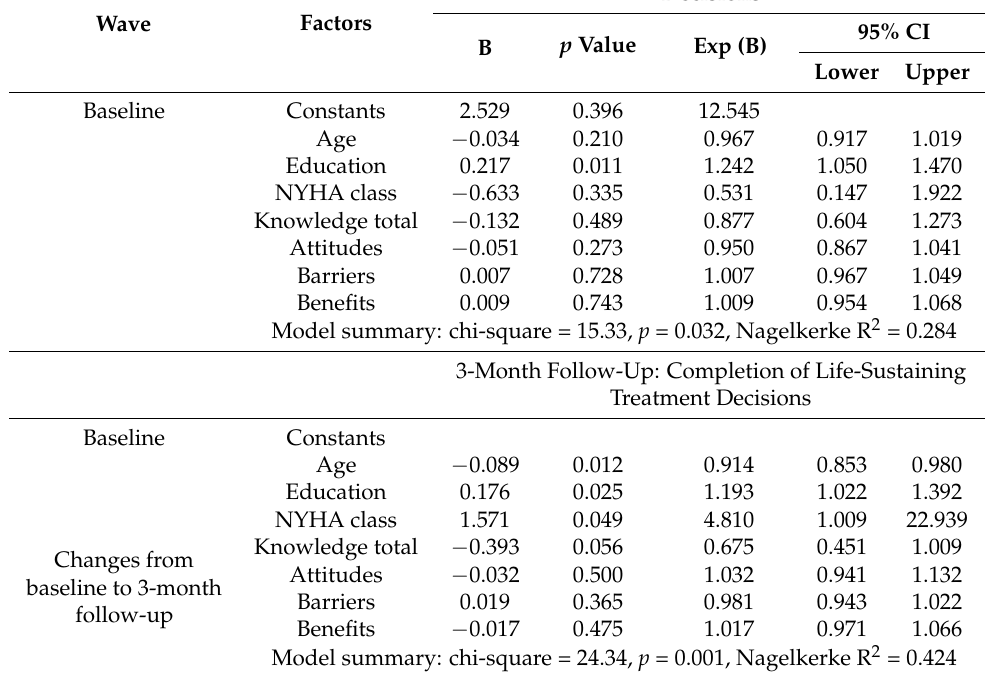
Table 4. Factors associated with completion of life sustaining treatment decisions at baseline and at 3-month follow-up: Logistic regression. Wave Factors